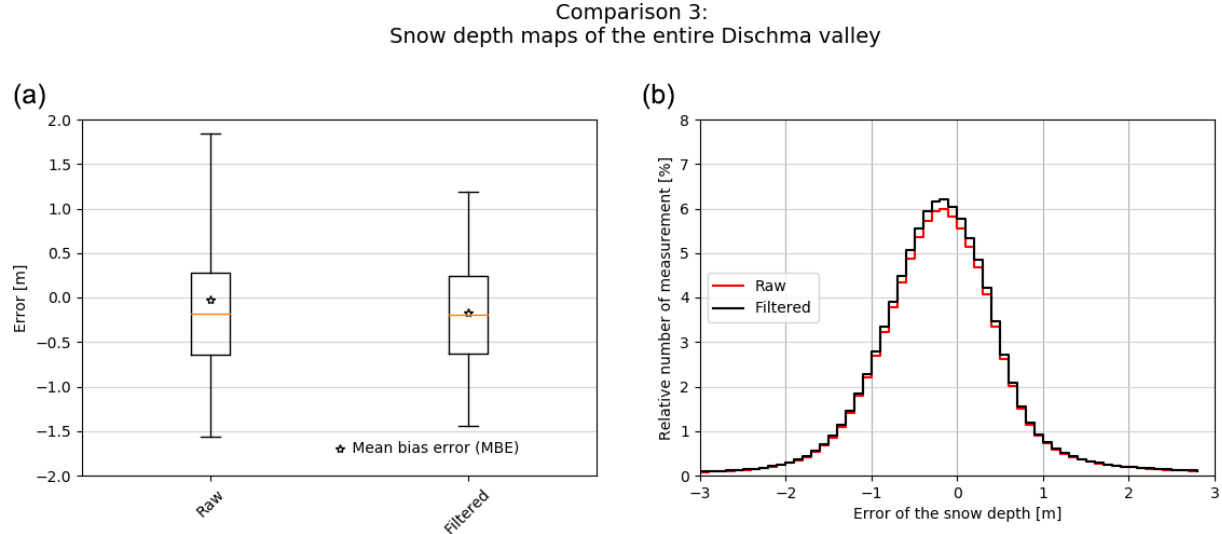
Figure 11. Box plot of comparison 3, the satellite data assessed against the airplane data. The orange line depicts the median, the star the mean bias error (MBE). The 25th and 75th quartiles are represented by the boxes and the 5th and 95th percentiles by the whiskers. The left box plot of the box plot graph illustrates the raw data and the right box plot the filtered data where plus or minus 2 SDs are removed. To better illustrate the distribution, the right plot shows a normalized histogram of the raw and the filtered data.